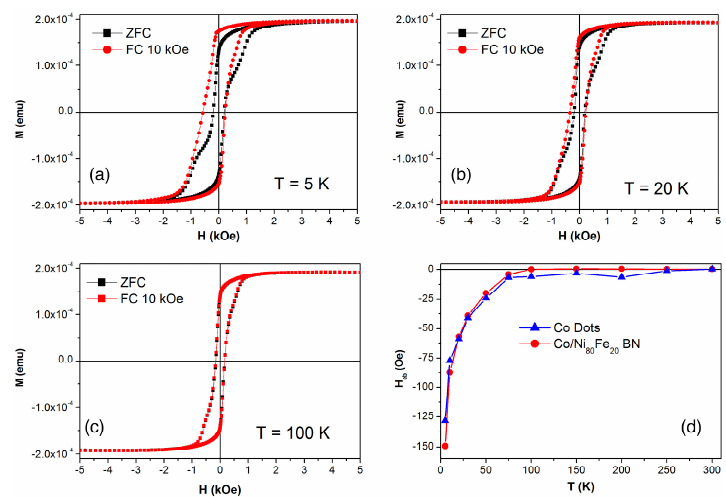
Figure 8. (Colour online) Hysteresis loops of the bi-component nanostructured system measured at 5, 20 and 100 K (panels ( a )–( c ) respectively), in field-cooled under 10 kOe applied field and zero-field cooled conditions. ( d ) Temperature dependence of the exchange bias field in Co dot arrays and bi-component nanostructured systems.